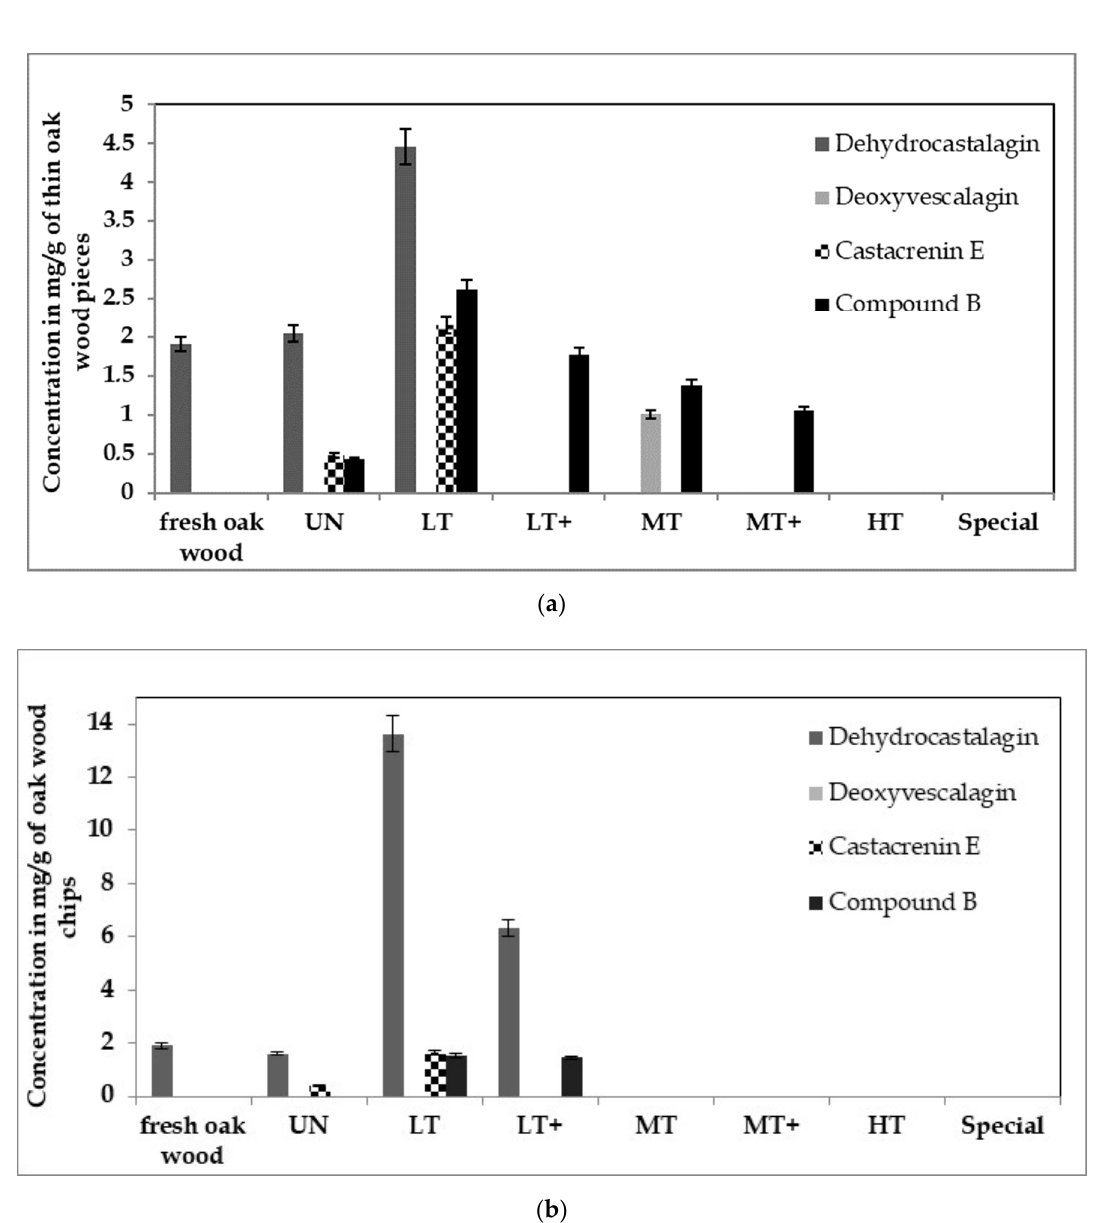
Figure 5. Concentration in mg/g of oak wood thin pieces ( a ), and chips ( b ). Untoasted (UN), light (LT),